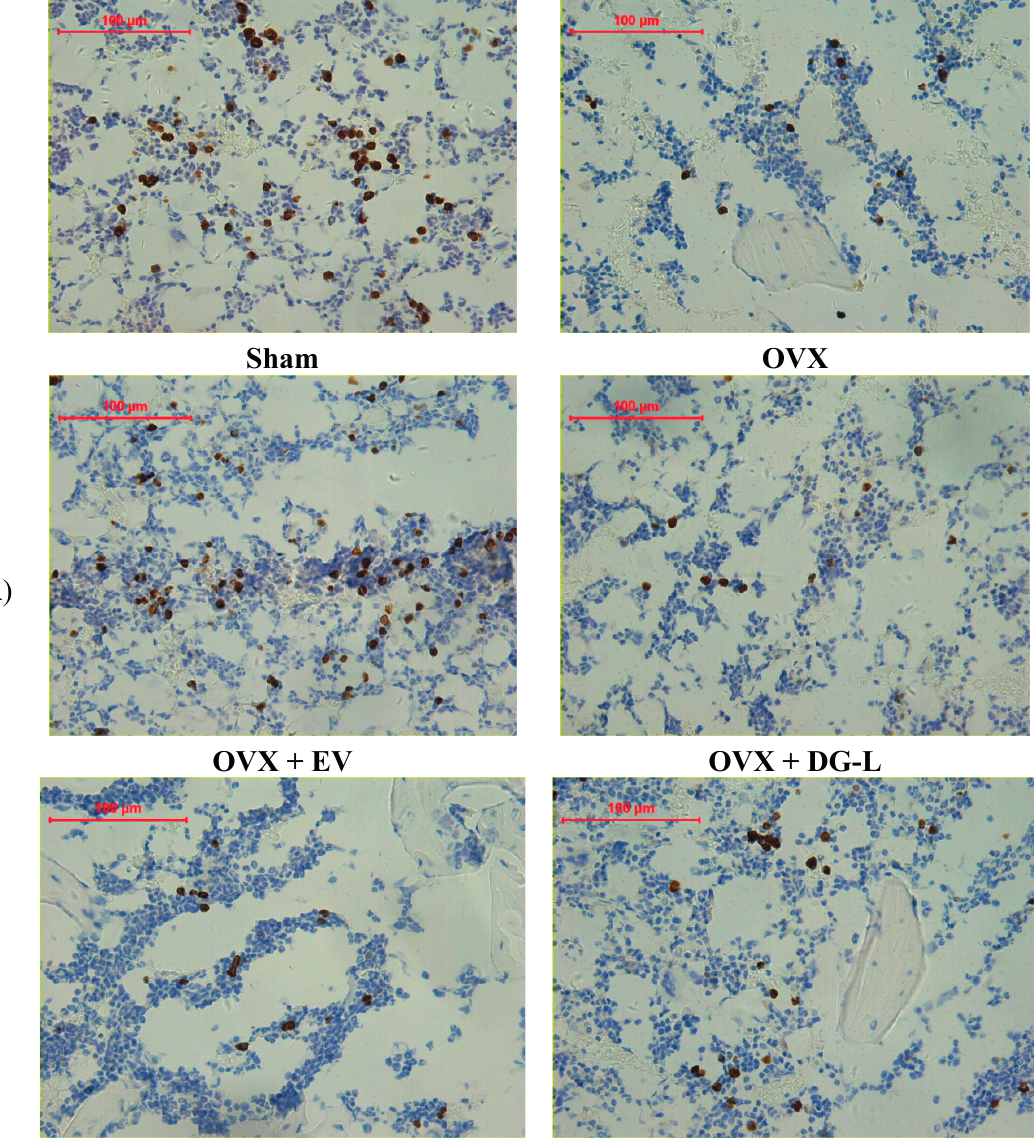
Figure 3. Effects of 12 weeks treatment on expression of OPG and RANKL mRNA in tibiae of rats. Expression level of OPG and RANKL mRNA was estimated by using in situ hybridization. ( A ) OPG mRNA expression; ( B ) RANKL mRNA expression, and ( C ) mRNA ratio of RANKL/OPG are shown. In panel ( C ), a, p < 0.01 vs. Sham group; b, p < 0.05